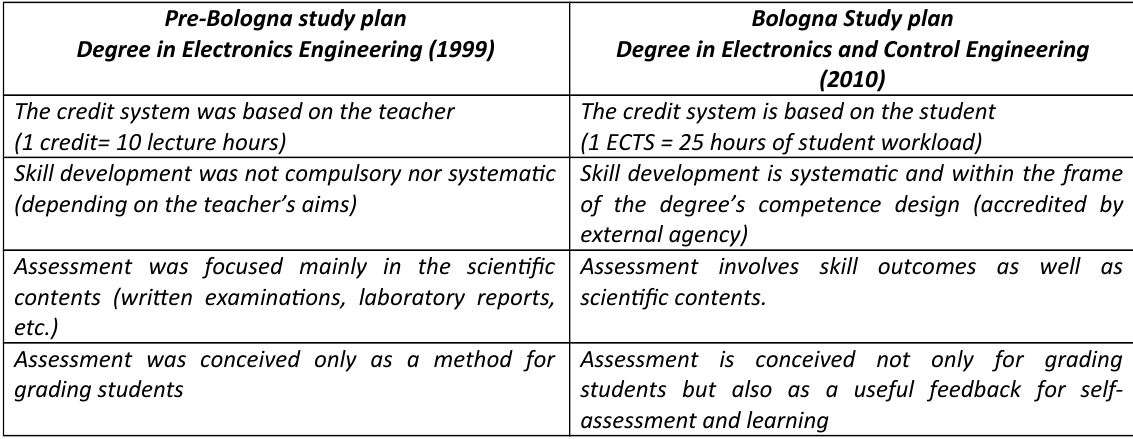
Table 3. Comparison, concerning skill development, between the pre-Bologna and the Bologna degree in Electronics Engineering at the University of